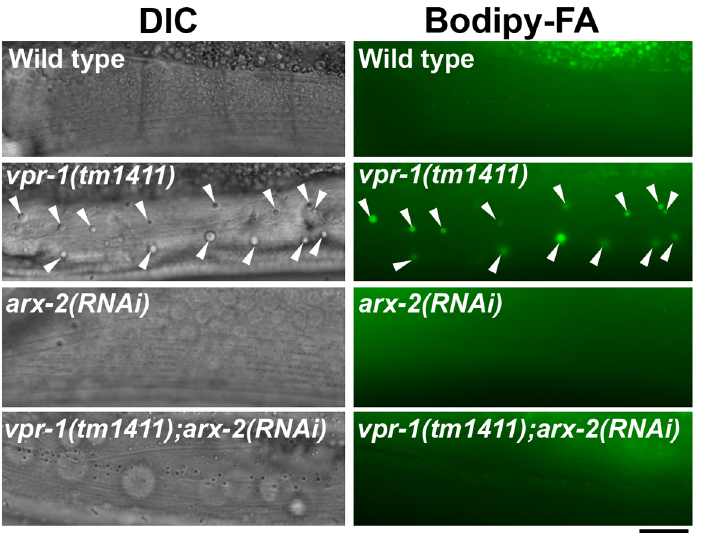
Figure 4. Effect of Arp2/3 inactivation on muscle fat levels. DIC and fluorescent images of muscle in live 3-day-old hermaphrodite worms fed Bodipy-FAs. arx-2 encodes the Arp2 component of the Arp2/3 complex. Arrowheads indicate Bodipy-FA-stained fat droplets. Bar, 5 m